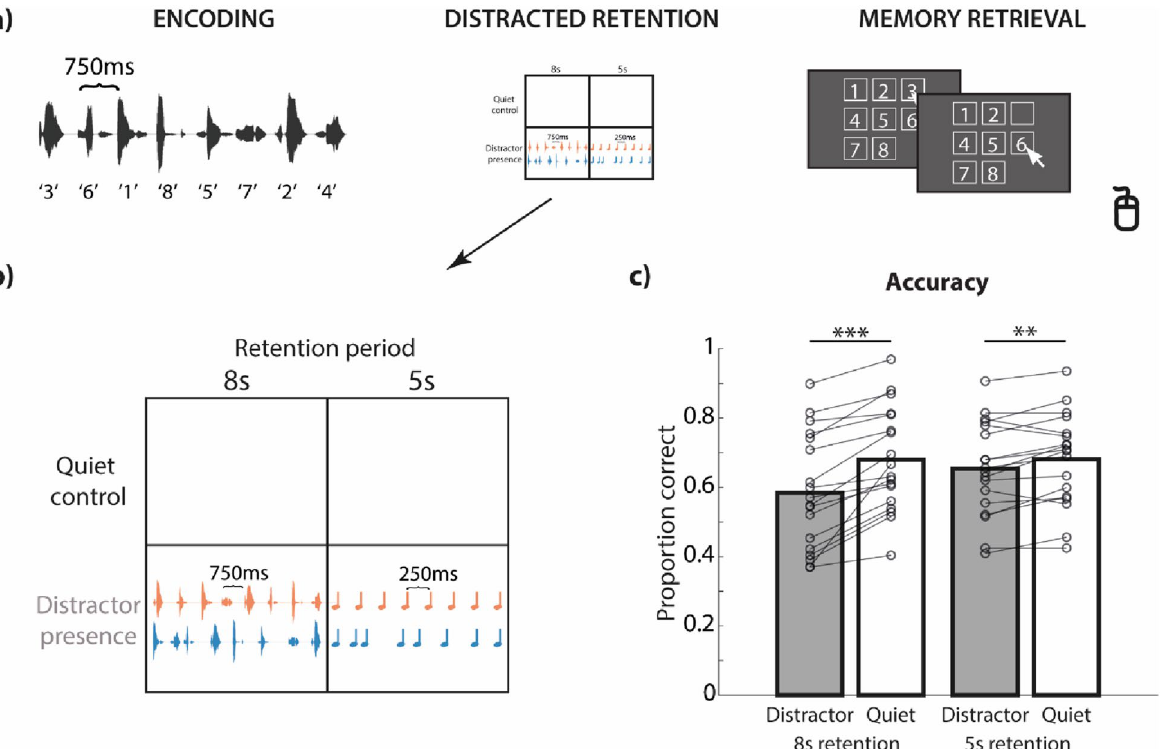
Figure 3. ( a ) Illustration of the trial structure in the control experiment, which was largely identical to the trial structure in Experiment 3. ( b ) Four conditions were implemented to cross the factors distractor (present vs absent) and duration of retention period (5 s vs 8 s). ( c ) Proportion correct scores in each condition in the control experiment. Lines show data from individual participants. **p < 0.01, ***p < 0.001.